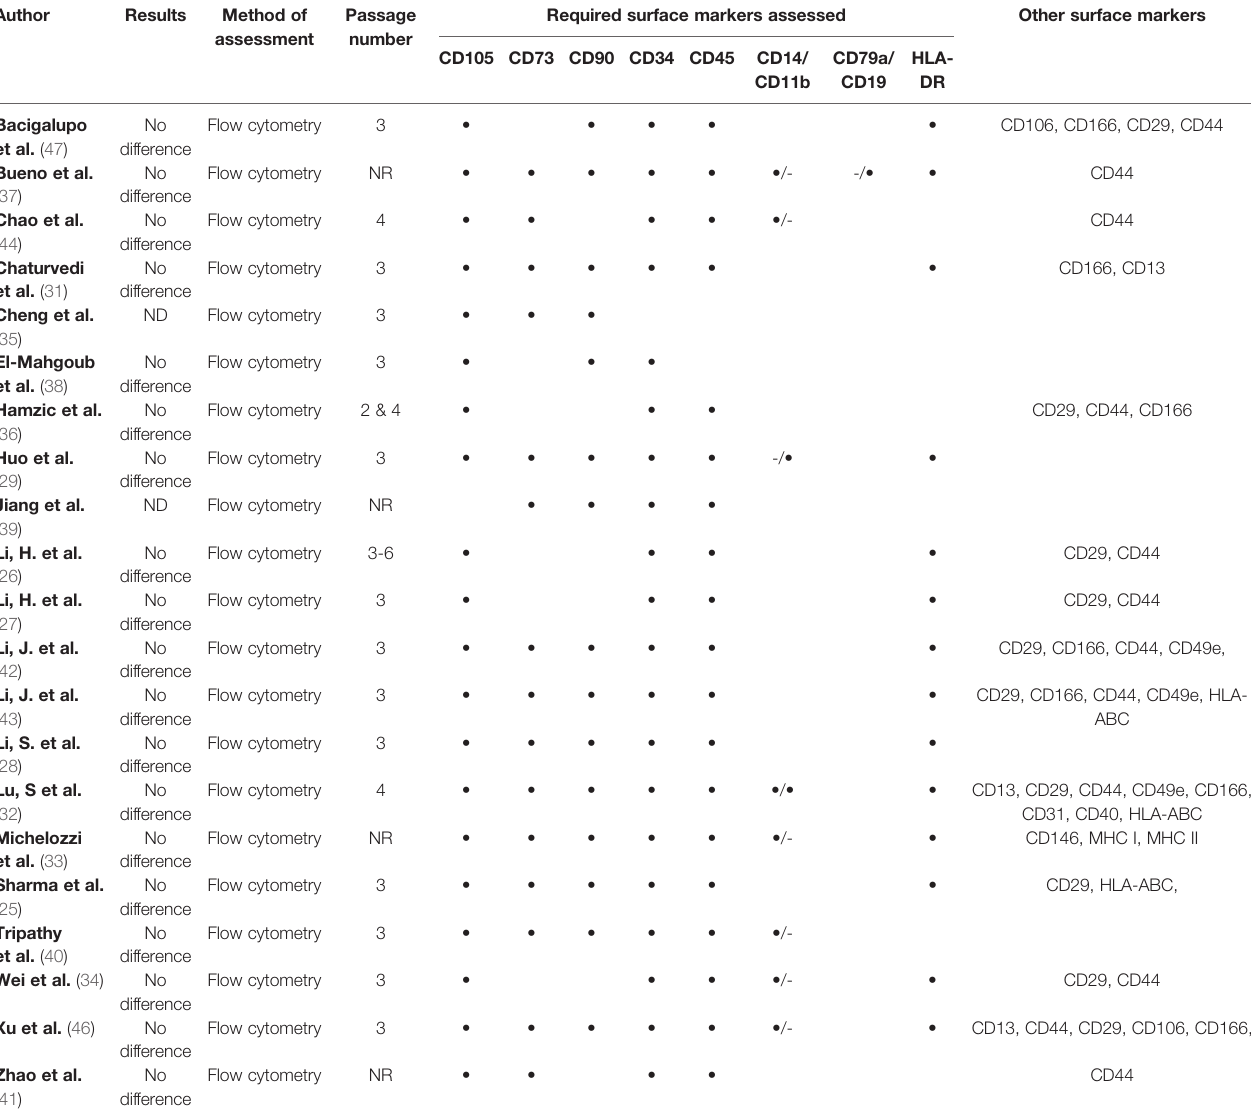
TABLE 4 | Assessment of